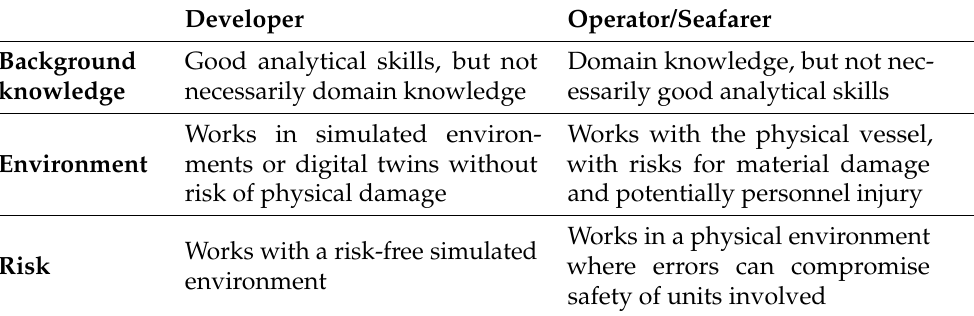
Figure 3. Illustration of ( a ) the developer’s and ( b ) the operator/seafarer’s different relations to the agent and the environment. Table 3. Differences between developer and